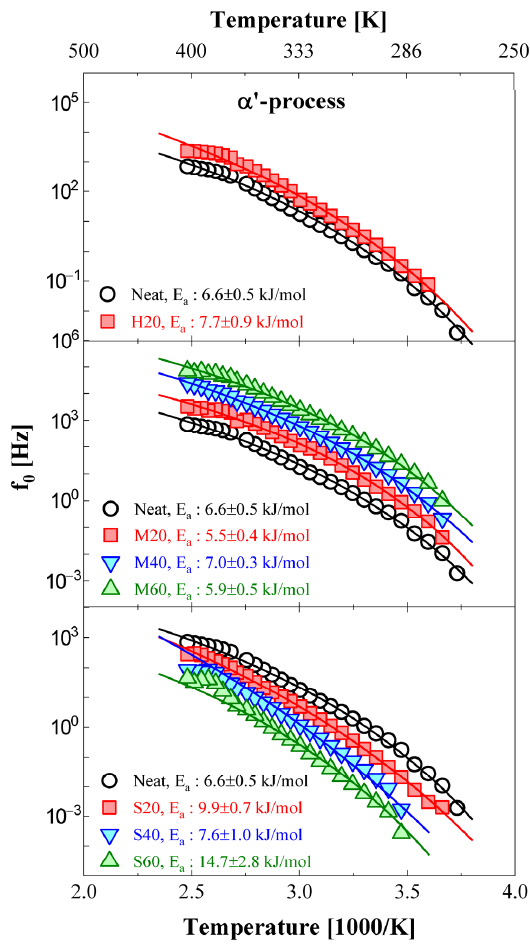
Figure 10. Temperature dependence of the relaxation rate for the α (cid:48) process on different filler loading